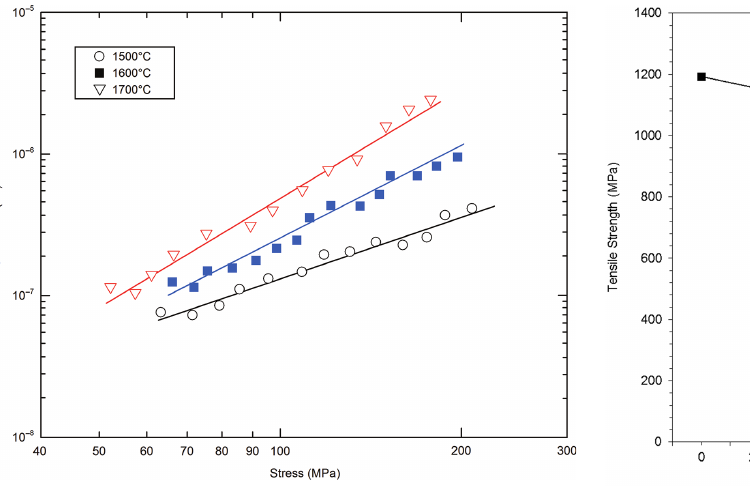
Figure 3: The compressive strain rate-stress behavior as a function of temperature for MgAl 2 O 4 -Y 3 Al 5 O 12 crystal.